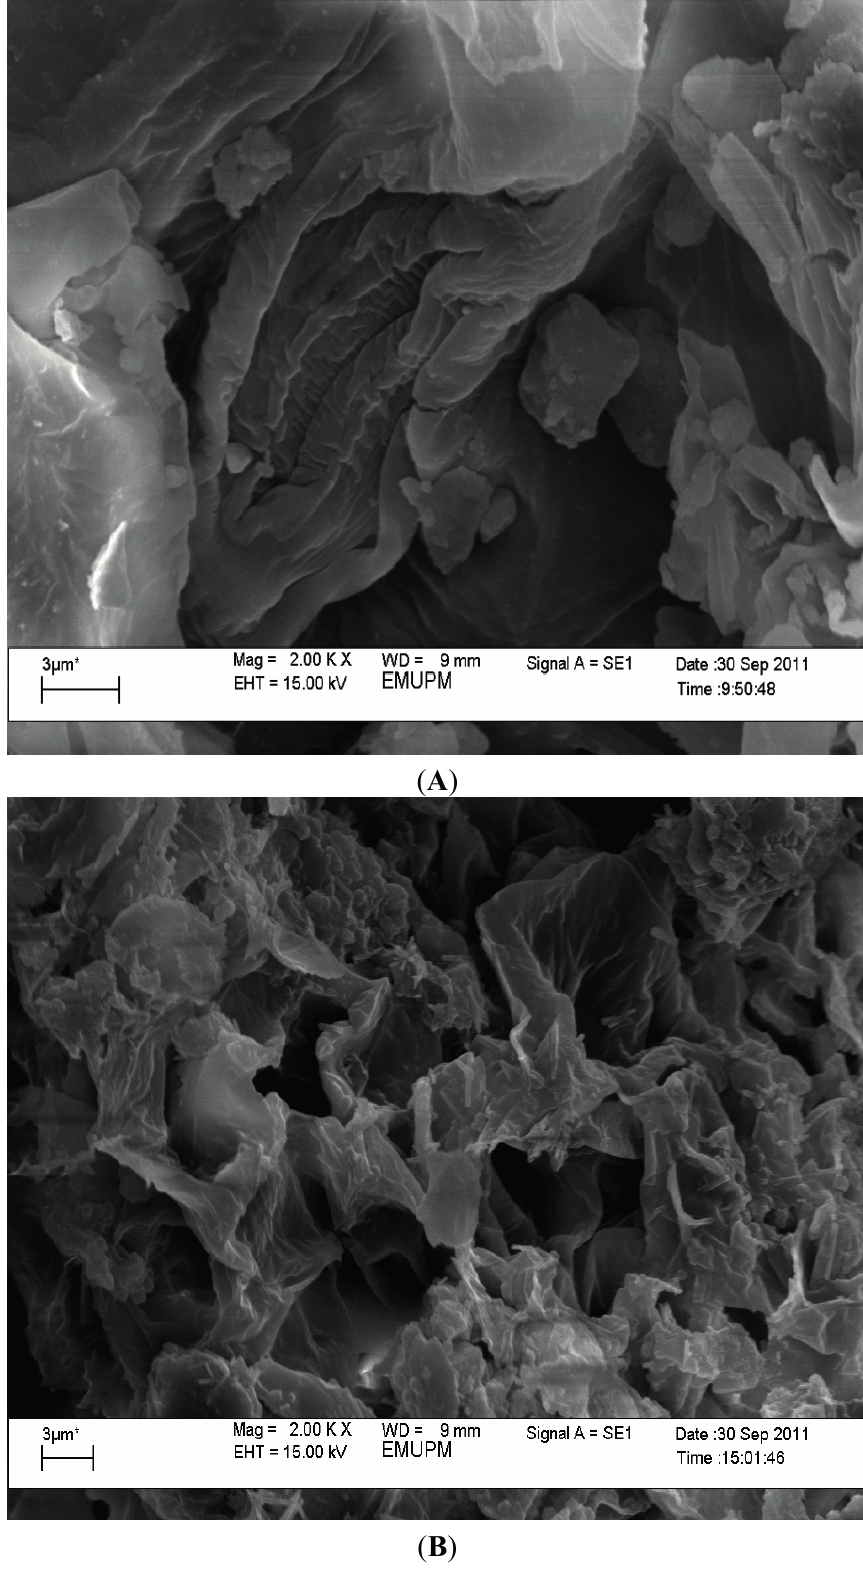
Figure 2. Scanning electron micrographs of ( A ) Orthosiphon stamineus before sonication treatment; ( B ) Orthosiphon stamineus after sonication treatment conditions at ethanol concentration: 54.13%, amplitude: 20%, duty cycle: 0.9 W/s and extraction time: 10